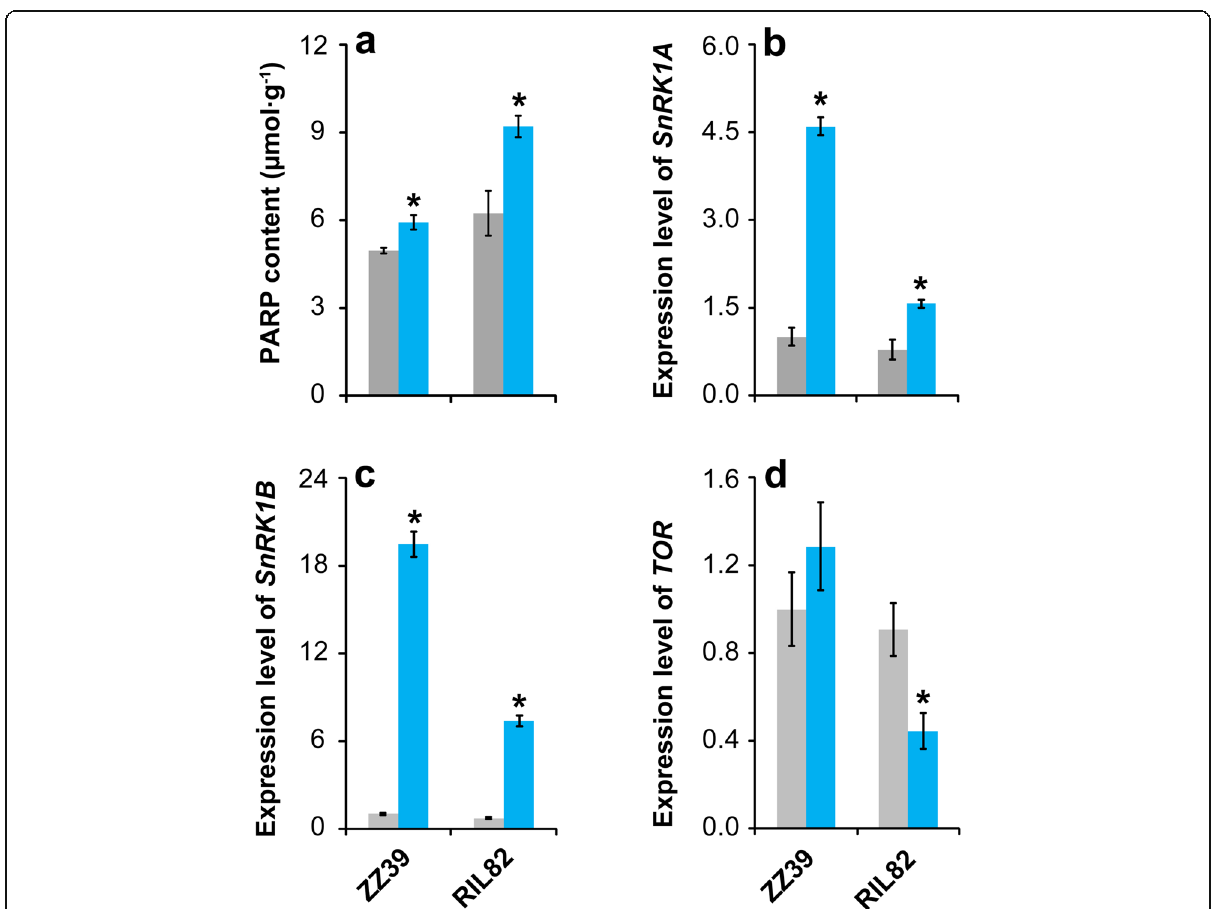
Fig. 6 Effects of cold stress on PARP content and expression levels of genes related to SnRK1 and TOR in rice leaves. PARP, Poly (ADP-ribose) polymerase; SnRK1, SNF1-related protein kinase; TOR, Target of rapamycin . Vertical bars denote standard deviations ( n = 3). A t -test was conducted to compare the difference between control and cold stress within a cultivar. * denotes P <